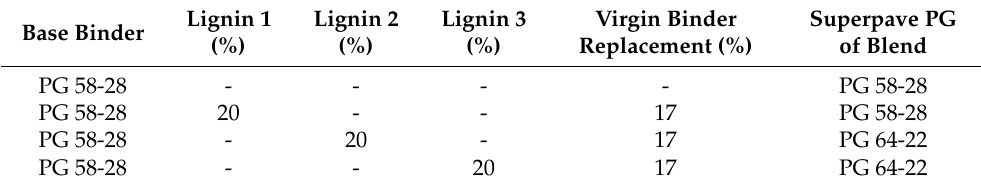
Table 1. Superpave PG Grades of the Studied Binder